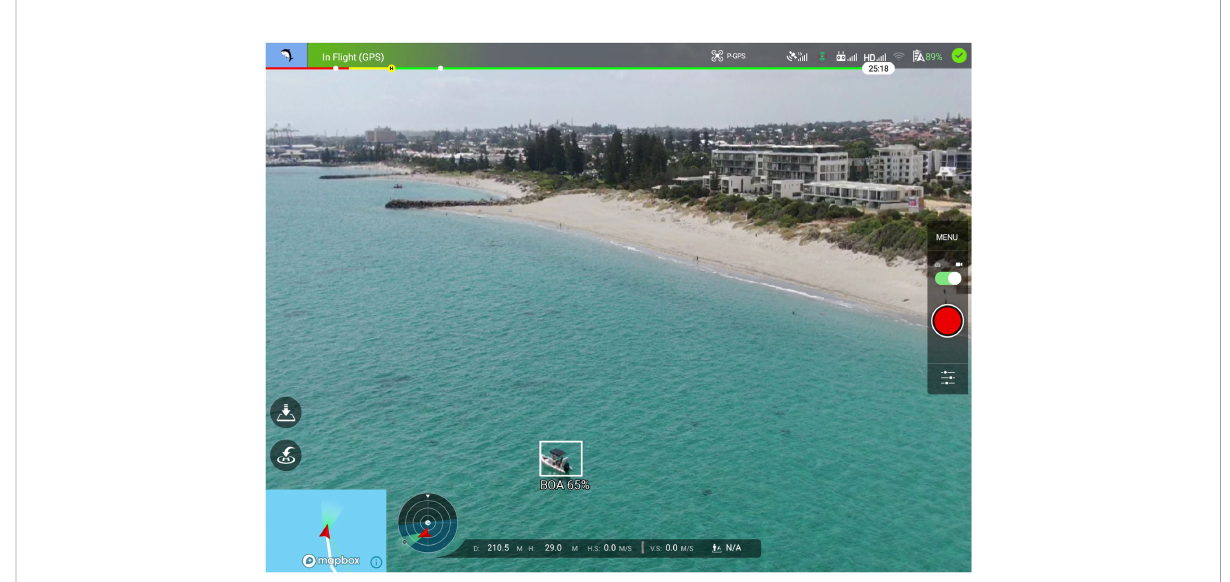
FIGURE 14 Screenshot of the mobile application fl ight screen as seen on a DJI CrystalSky Android tablet. The top bar includes information on (from left to right), fl ight status, GPS signal lock, GPS signal strength, telemetry signal strength, video signal strength, WiFi connectivity of tablet, drone battery status and controller connection status. The widget on the right hand side exposes camera settings and allows the user to record videos, or take a pictures, that are saved to the drone ’ s on-board storage. On the left hand side are controls to command the drone to land (upper button) and return to home (lower button). Along the bottom of the screen is information on drone location and movement. From left to right: map widget, compass/heading widget, distance from controller, height, horizontal speed and vertical speed. The deep learning model has identi fi ed a boat on the current frame and annotated it with a white box and label ‘ BOA 65% ’ , indicating the con fi dence of the detection. Note that the location of the box and the boat do not coincide exactly due a short time lag between detecting the boat and drawing the